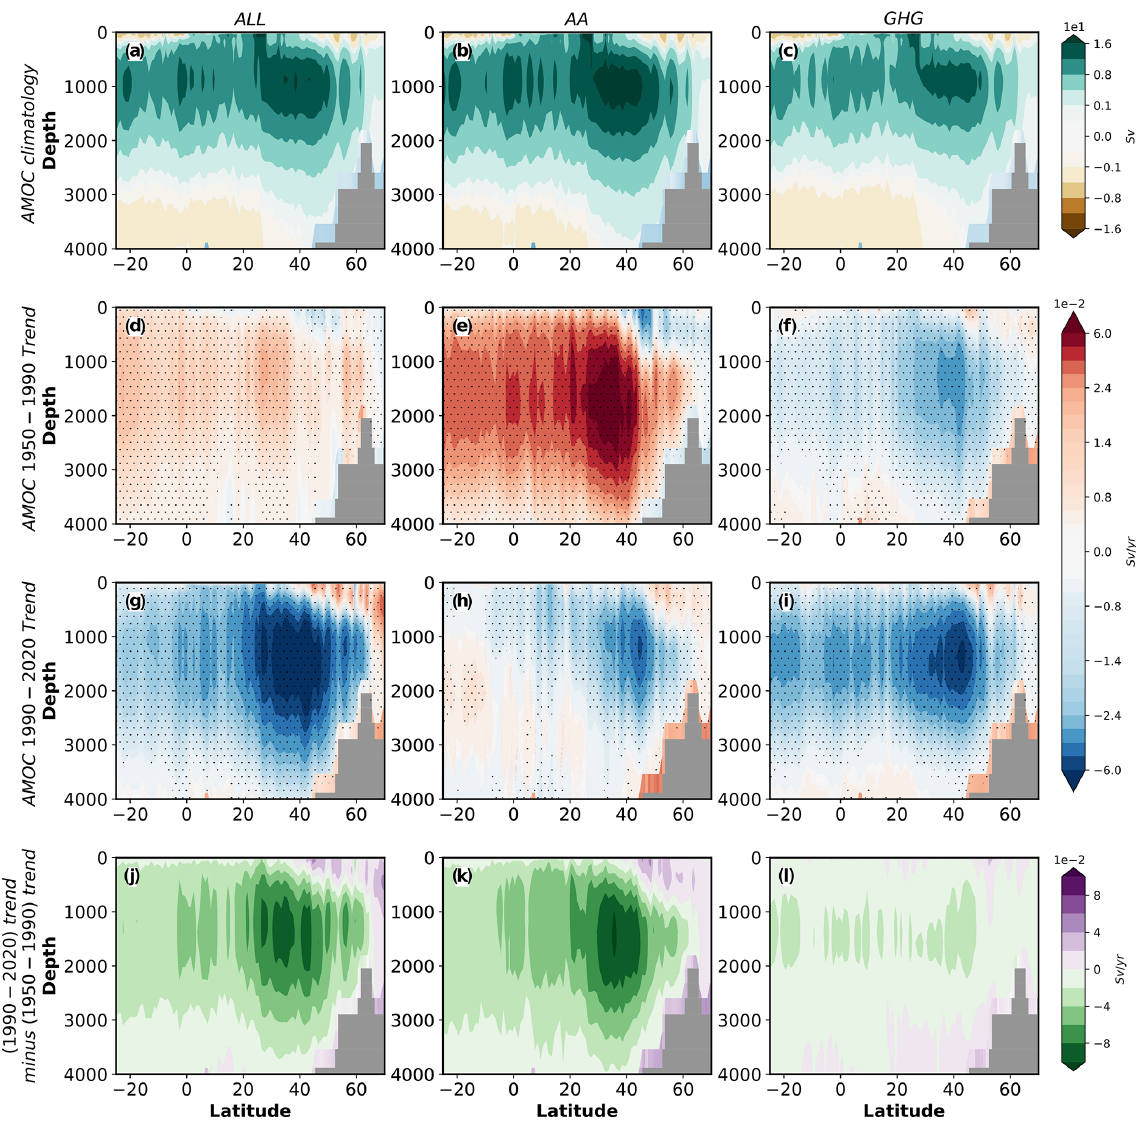
Figure 13. The 1950–2020 ensemble mean annual mean Coupled Model Intercomparison Project phase 6 Atlantic meridional streamfunction in depth–latitude space: zonal mean (a–c) 1950–1990 climatology, (d–f) 1950–1990 trends, (g–i) 1990–2020 trends, and (j–l) trend “shift” (1990–2020 trend minus 1950–1990 trend) for (a, d, g, j) all forcing, (b, e, h, k) anthropogenic aerosol forcing, and (c, f, i, l) GHG forcing. Symbols designate trend significance at 95% confidence level based on a t test. Streamfunction trend values are in Svyr − 1